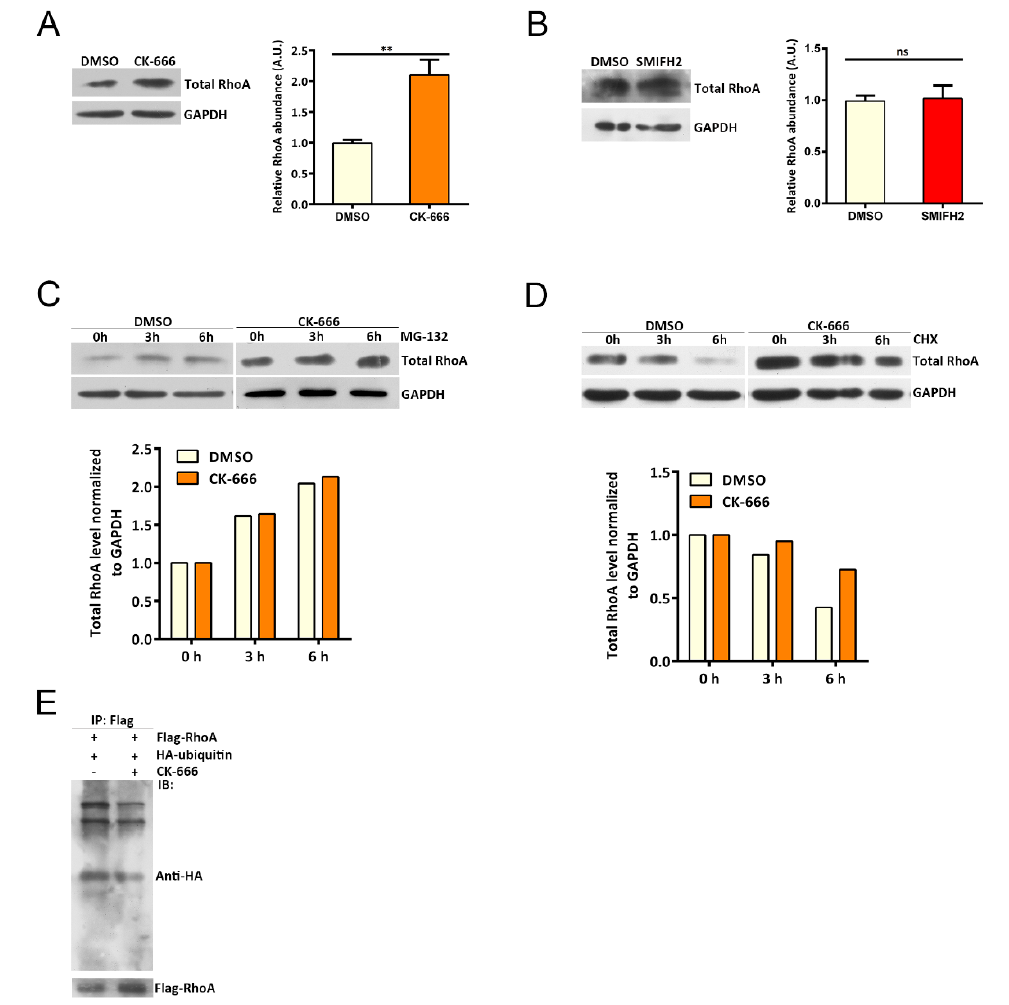
Figure 3. RhoA abundance is increased under Arp2 / 3 perturbation. ( A ) Western blot showing total RhoA abundance under DMSO or CK-666 treatment: error bar indicates SEM, ** p < 0.05, by student’s t test. n = 3 independent experiments. ( B ) Western blot showing total RhoA abundance under DMSO or SMIFH2 treatment: error bar indicates SEM, ns, no significant difference, by student’s t test. n = 3 independent experiments. ( C ) Western blot showing total RhoA level change in Hela cells treated with MG-132 for 0 h, 3 h, and 6 h with or without CK-666. ( D ) Western blot showing total RhoA level change in Hela Cells treated with cycloheximide for 0 h, 3 h, and 6 h with or without CK-666. ( E ) Western blot showing RhoA ubiquitination level in HEK293T cells under DMSO or CK-666 treatment. HEK293T